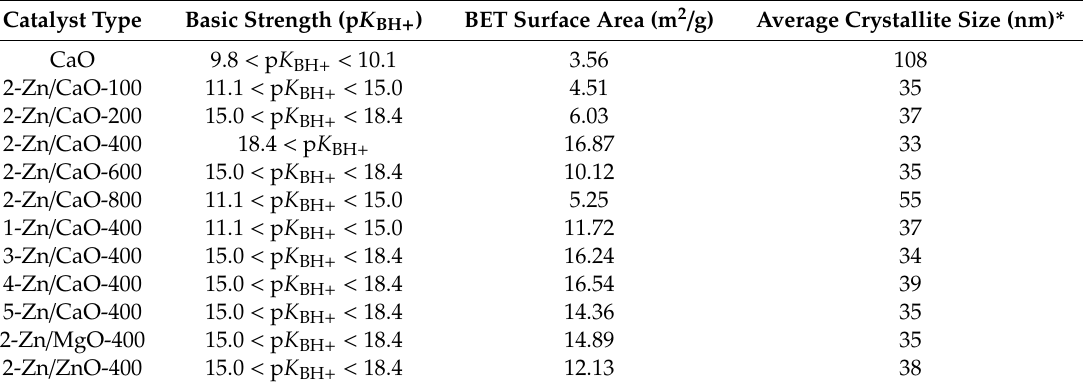
Table 1. E ff ect of calcination temperature, Zn ion concentration, and di ff erent oxides on the basic strength, surface area, and crystallite size. BET: Brunauer–Emmett–Teller.